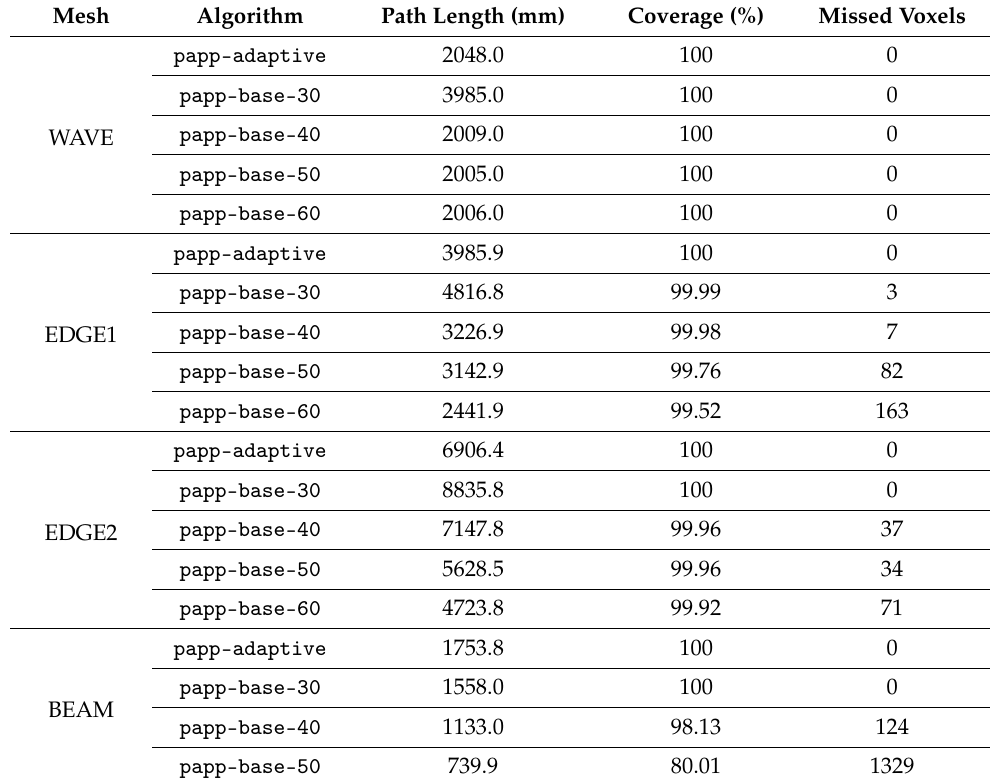
Table 1. Comparison of different Cartesian path planning algorithms for four different mesh objects. The path length is the combined Cartesian path length in millimeters. The coverage indicates the percentage of voxels that are inspected using the generated path. The last column states the total number of missed